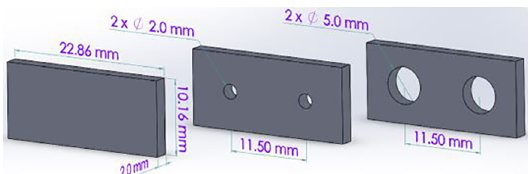
Figure 1. Dimensions of regular sample and FSS structures.